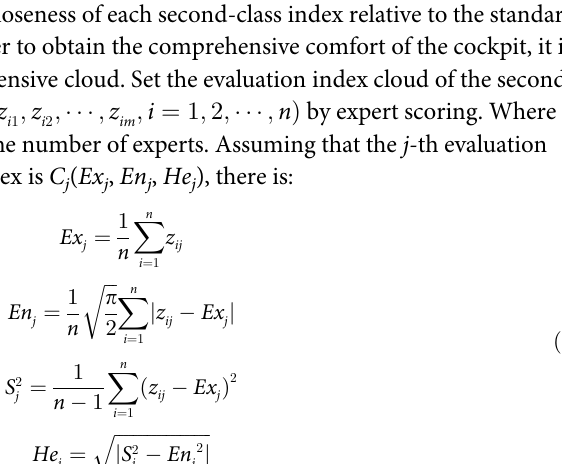
ffiffiffiffiffiffiffiffiffiffiffiffiffiffiffiffiffiffiffiffiffi q j S 2 (cid:0) En j